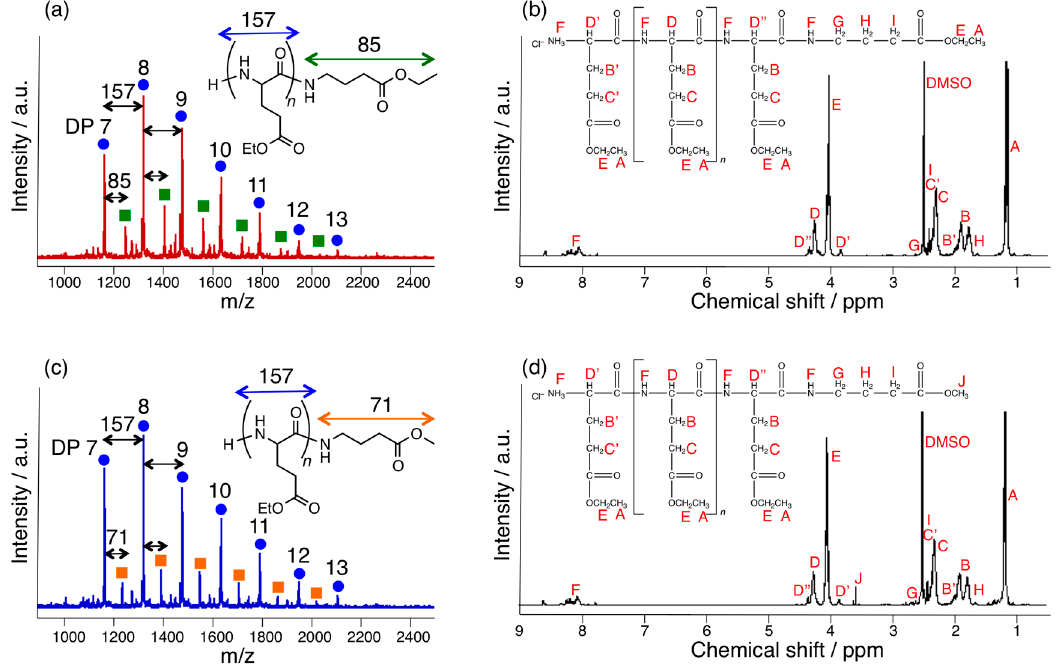
Figure 2. MALDI-TOF MS ( a , c ) and 1 H–NMR ( b , d ) spectra of the papain-catalyzed reaction product using Glu(Et) 2 with nylon 4Et ( a , b ) or nylon 4Me ( c , d ) as substrates. Mass spectra were obtained in the linear positive mode using HABA and Na-TFA as the matrix and cationic reagent, respectively. Peaks with blue circles denote oligo(GluEt) with various DP, whereas peaks with green ( a ) or orange ( c ) squares denote oligo(GluEt) with a nylon 4Et or nylon 4Me, respectively. DMSO- d 6 was used as the solvent in NMR measurements.